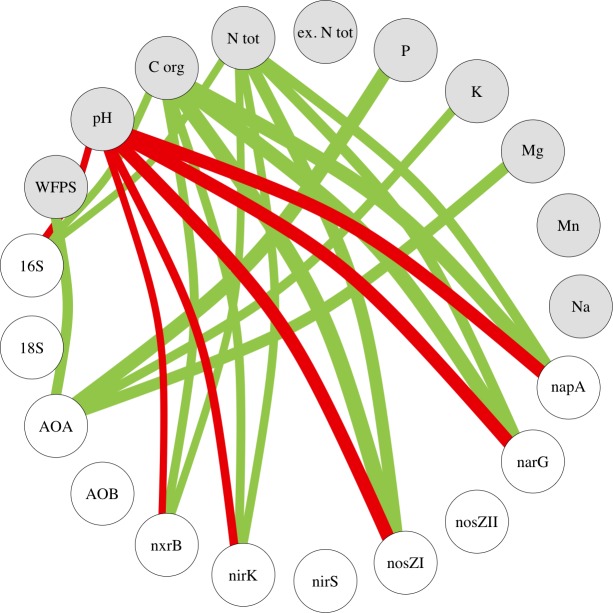
Network analysis of the relationships between gene abundances (white nodes) and soil properties (gray nodes). Lines are based on the thresholds of Spearman’s rank correlations, with r > |0.7| and p < 0.001 (S4 Table), across all replicate plots of paired temperate agroforestry and monoculture cropland or open grassland systems in all three soil types. Green lines represent positive and red lines represent negative correlations. The line’s width is proportional to the absolute magnitude of the correlation coefficient. 16S = bacterial 16S rRNA gene abundance, 18S = fungal 18S rRNA gene abundance, AOA = ammonia-oxidizing archaea amoA gene abundance, AOB = ammonia-oxidizing bacteria amoA gene abundance, nosZI = nosZ clade I gene abundance, NosZII = nosZ clade II gene abundance, P = plant-available P, ex. N tot = total extractable N, N tot = total N, C org = organic C, WFPS = water-filled pore space.